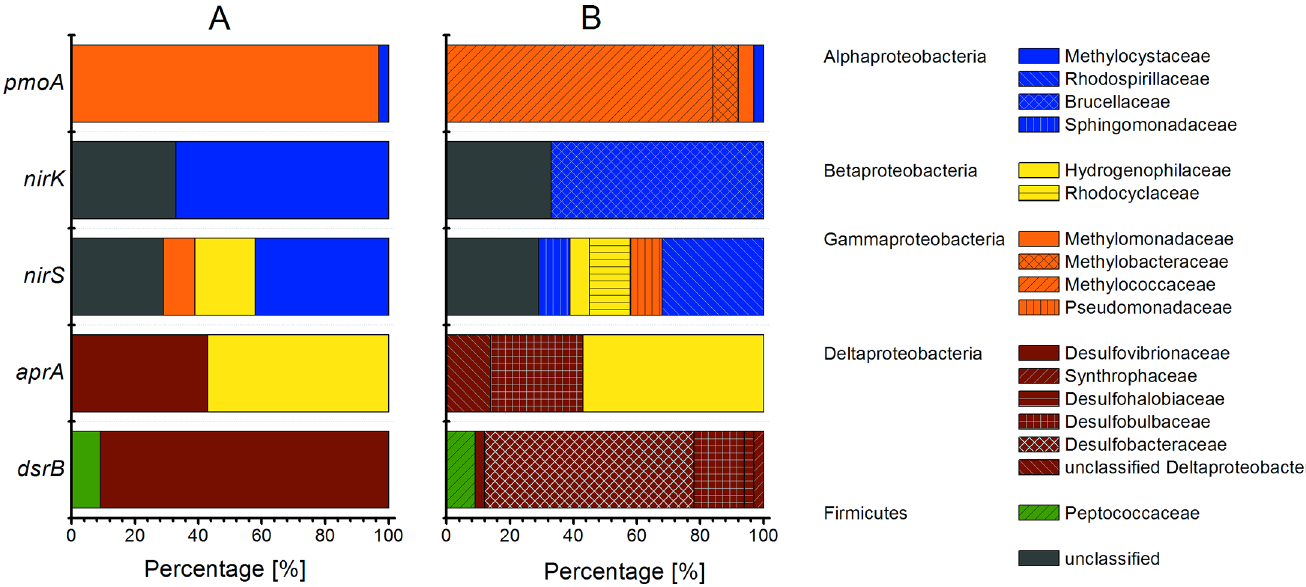
Fig 5. Bar chart of analyzed functional genes and their phylogenetic classification. (A) Phylum-level classification of functional gene sequences; (B) Phylogenetic classification of the sequences to their closest related family. Colors correspond to encountered phyla, while patterns indicate families.